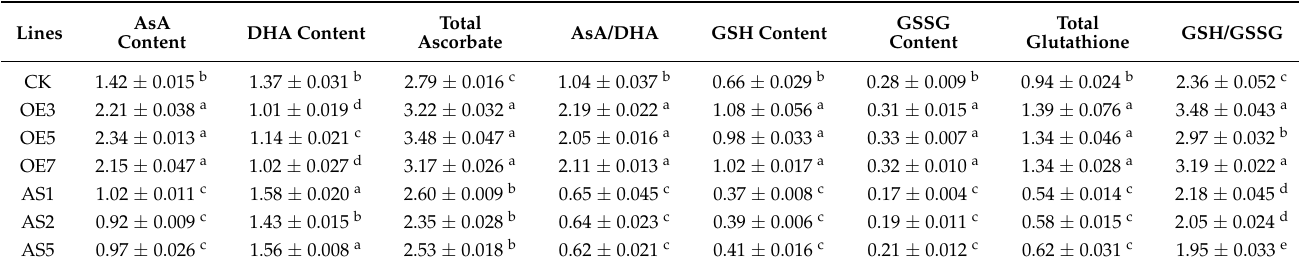
Table 2. Ascorbate–glutathione (AsA-GSH) cycle in the leaves of control, CsGSH2 -overexpressing (OX), and antisense (AS) plants 48 h after 2 mM propamocarb application.